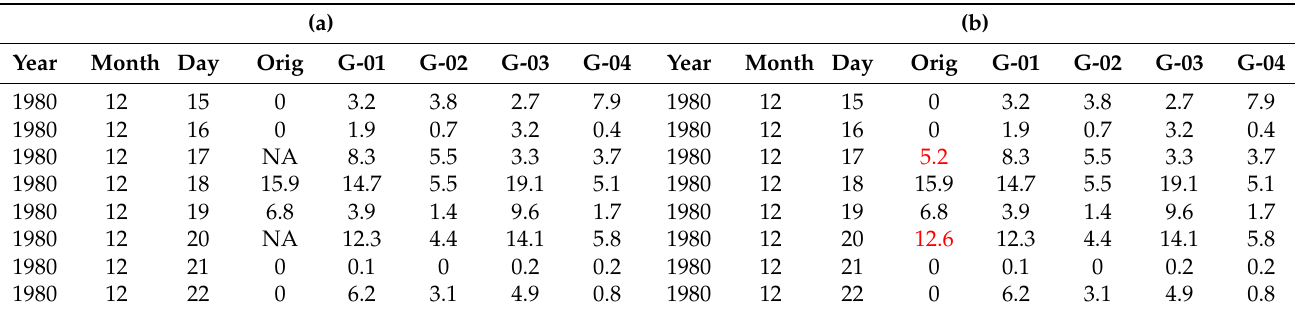
Table 1. Precipitation series with missing data, represented by NA, from the Ouricuri station (WMO code: 82753)— Pernambuco (a) and after the gaps have been filled (imputed values in red; b). The original data of the station (Orig column) are followed by the nearest gridded series, which constitute the set of predictors (G-01, G-02, G-03 and